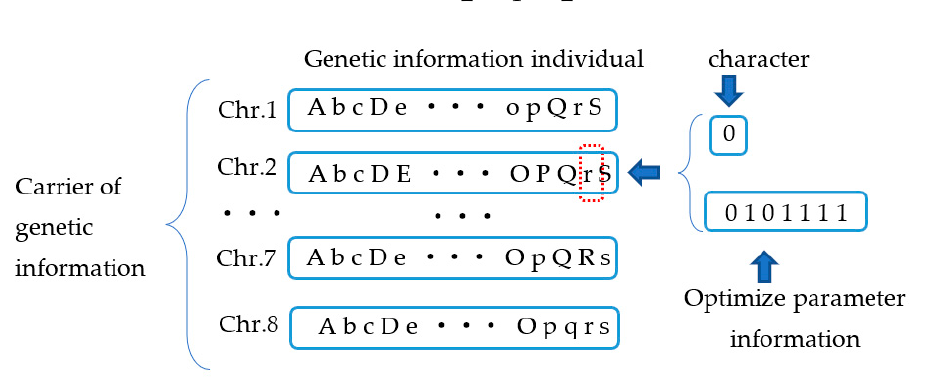
Figure 7. Genetic information composition map.